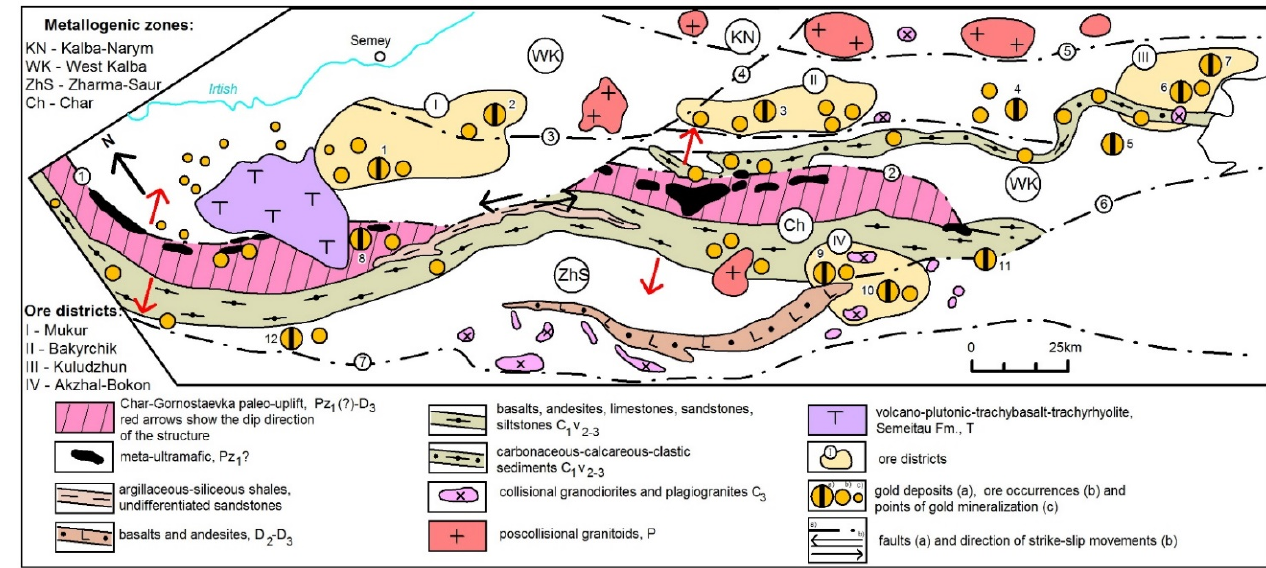
Figure 9. Gold deposits in the West Kalba and Zharma ‐ Saur belts. Numbers in circles stand for names of faults: 1 = Gornostaevka; 2 = Char; 3 = West Kalba; 4 = Znamensky; 5 = Terekta; 6 = Sar ‐ dzhal; 7 = Baiguzin ‐ Bulak. Arabic numbers stand for names of deposits: 1 = Zherek; 2 = Kedey; 3 = Bakyrchik; 4 = Sentash; 5 = Jumba; 6 = Kuludzhun; 7 = Layly; 8 = Suzdal; 9 = Akzhal; 10 = Boko; 11 = Ashaly; 12 = Zhanan.